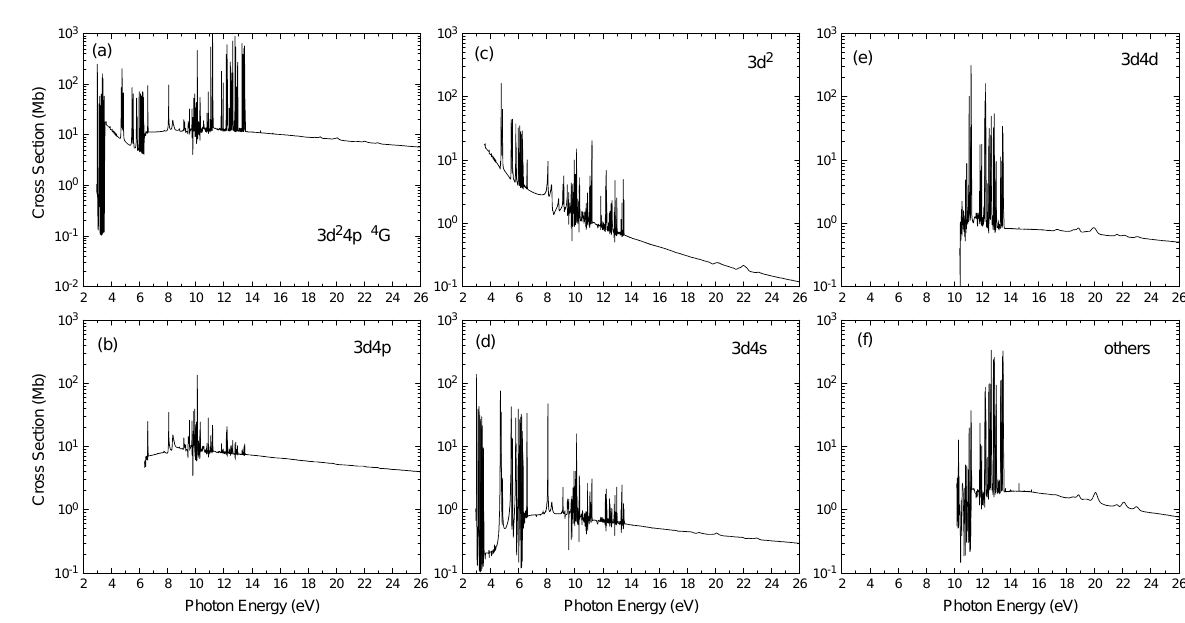
Figure 4. Photoionization cross-sections from the excited 3 d 2 4 p 4 G state of Sc. ( a ) shows total cross-sections from the present BSR-81 model whereas ( b – f ) show summed partial cross-sections for leaving the residual Sc + ion in the final states of the 3 d 4 p , 3 d 2 , 3 d 4 s , and 3 d 4 d configurations, respectively, along with the contribution of all other channels.